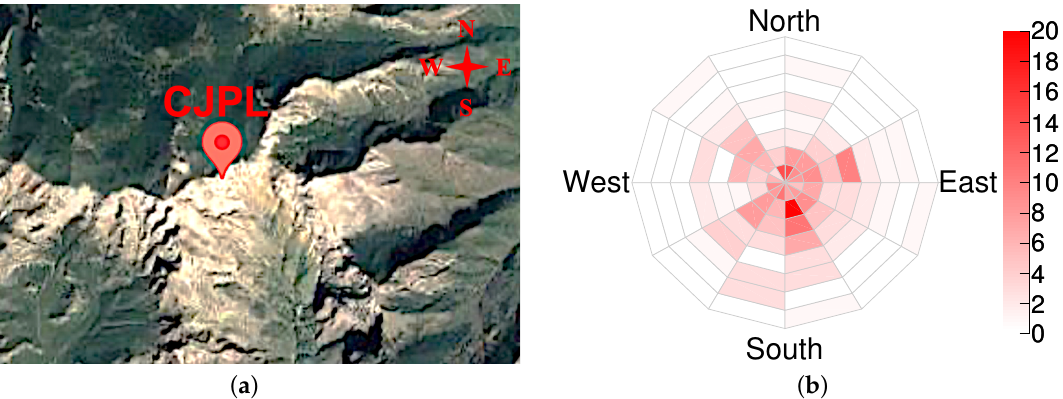
Figure 5. The satellite image of the Jinping Mountain terrain ( a ) was extracted from Google Maps. In the measured event number radar image ( b ), the color represents the event number in each bin. The radial dimension is the cos θ zen of the muon direction; the innermost point and the outermost circle correspond to cos θ zen = 1 (vertical upward direction) and cos θ zen = 0.2, respectively. There are event number excesses in four main directions (two in the south and two in the north) in the radar image, which match the ravines seen in the satellite